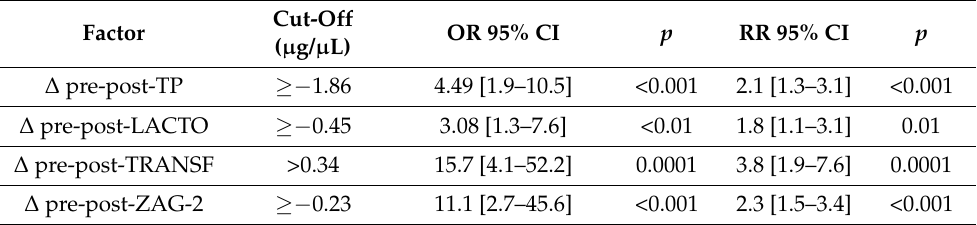
Table 5. Odd ratio and risk ratio for oGVHD onset of the difference pre-post-HSCT of tear total protein (TP), lactoferrin (LACTO), transferrin (TRANSF), and zinc-alpha-2-glycoprotein